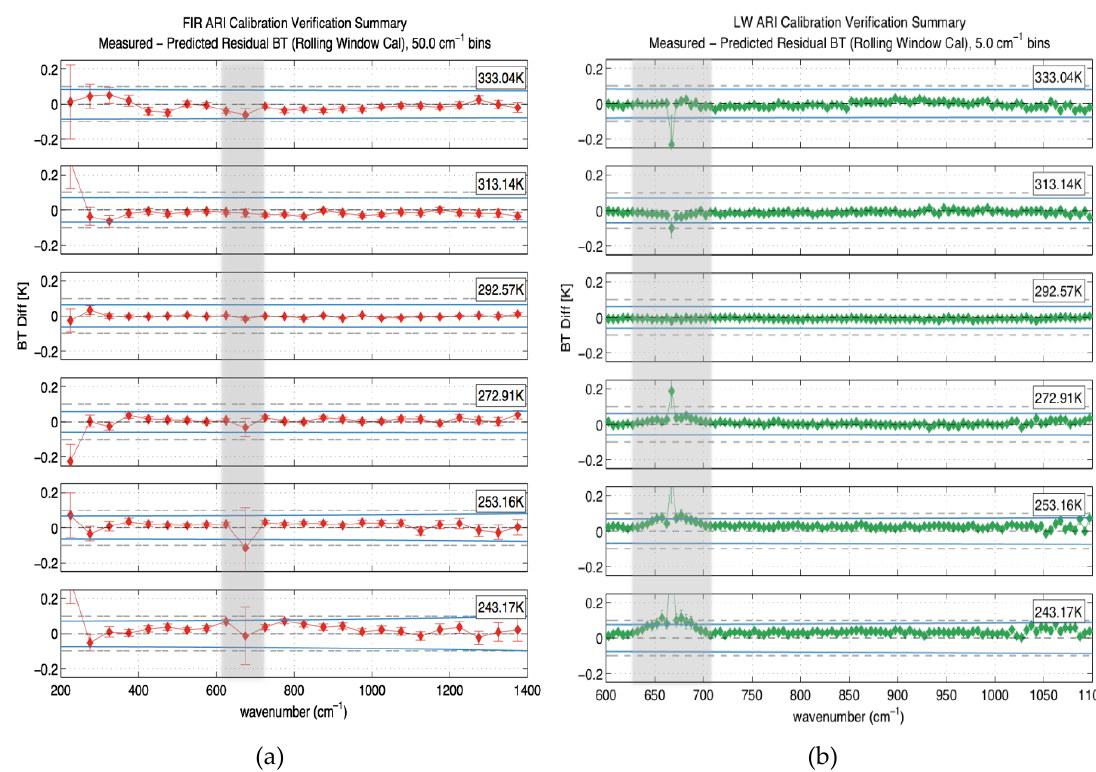
Figure 16. ARI calibration verification in the laboratory conditions under dry air purge, following the resolution of the fore-optics stray-light issue discovered during vacuum testing. Observed–predicted OARS brightness temperature residuals for the ( a ) DTGS detector (averaged over 50 cm − 1 for noise reduction) and ( b ) the MCT (averaged over 5 cm − 1 for noise reduction). The di ff erences generally fall inside the ± 0.1 K boundaries shown, and the improvement for both bands compared to vacuum tests is evident. In the far-infrared from 200–300 cm − 1 the low signal to noise due to the less than optimum beamsplitter coating causes a small bias. Total (calibration and calibration verification) radiometric uncertainty (k = 3) for the laboratory environment is shown in blue, and the grey dashed lines indicate ± 0.1 K. Error bars represent statistical error only (k = 1 standard error). The predicted radiances for the OARS do not include atmospheric absorption calculations and as a result, the 15 µ m CO2 band absorption signature (shaded in grey) is evident in the residual.